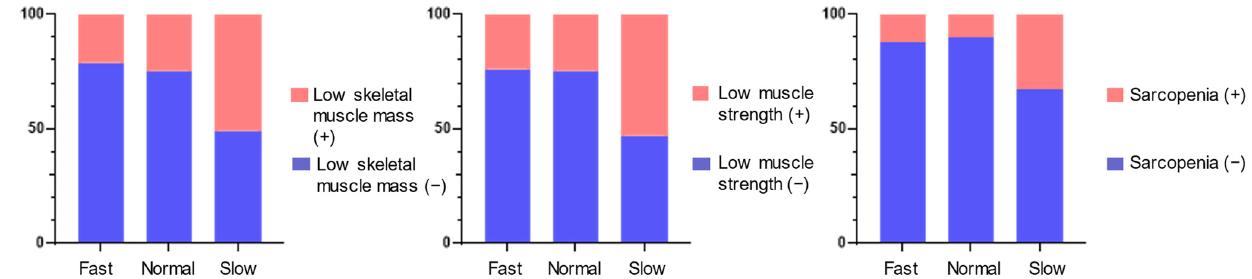
Figure 2. Proportions of low skeletal muscle mass, low muscle strength and sarcopenia among fast-, normal- and slow-speed eating groups. Relationships between eating speed and the presence of low skeletal muscle mass, low muscle strength, or sarcopenia are shown in Table 2. After adjusting for covariates, compared to slow eaters, the odds ratio of having low skeletal muscle mass among fast- and normal-speed eaters was 0.27 [95% confidence interval (CI): 0.12–0.57, p < 0.001] and 0.32 (95% CI: 0.14–0.71, p = 0.005), respectively; the odds ratio of having low muscle strength among fast- and normal-speed eaters was 0.28 (95% CI: 0.12–0.65, p = 0.003) and 0.22 (95% CI: 0.09–0.57, p = 0.002), respectively; and the odds ratio of having sarcopenia among the fast- and normal-speed eaters was 0.31 (95% CI: 0.12–0.80, p = 0.016) and 0.18 (95% CI: